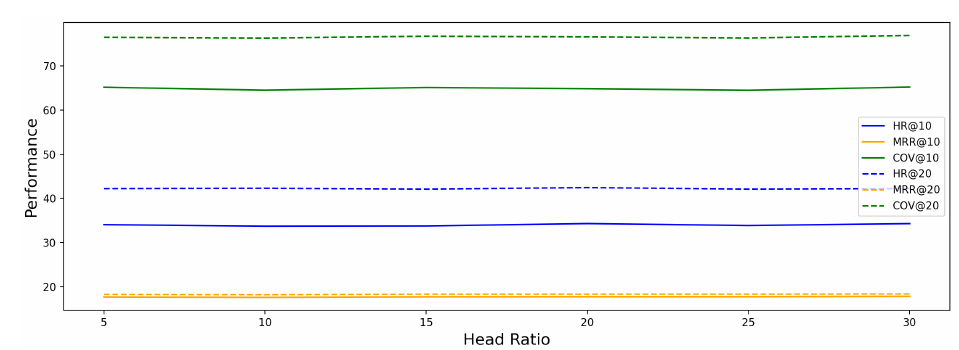
Figure A1. We compare the performance of LA in various head ratio from 5% to 30%. The legend shows the metrics. We examine the performance in SRGNN model using Digineitca